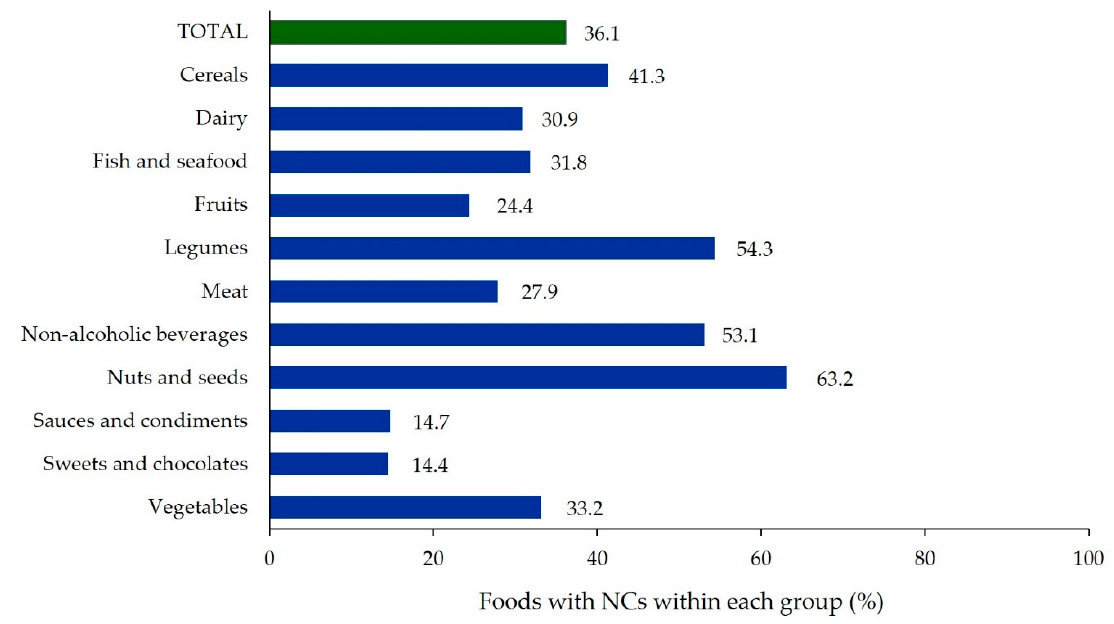
Figure 1. Foods with NCs by group (%). (Note: percentage was calculated using data in Table